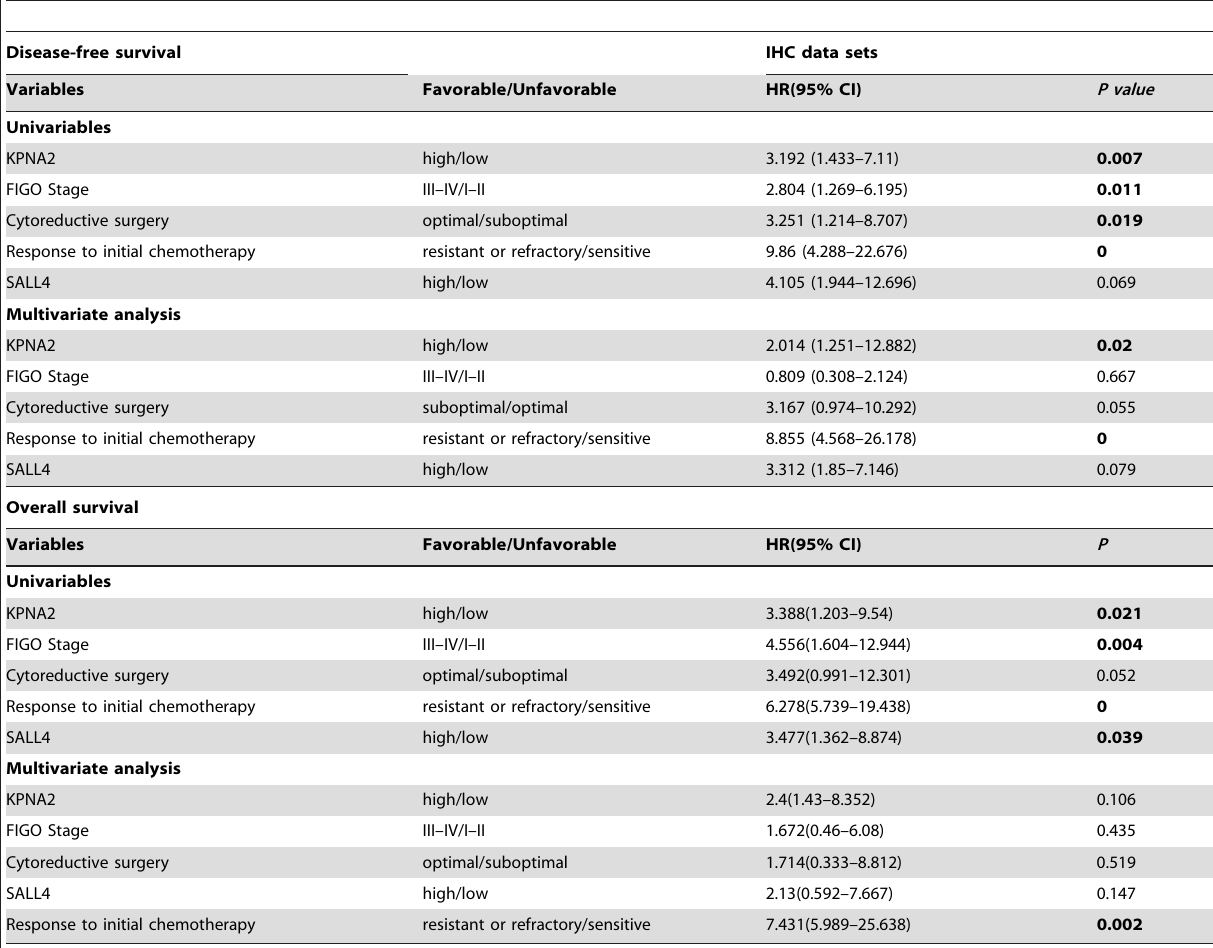
Table 4. Cox regression analysis of the various factors associated with disease-free survival and overall survival in OMGCT patients.